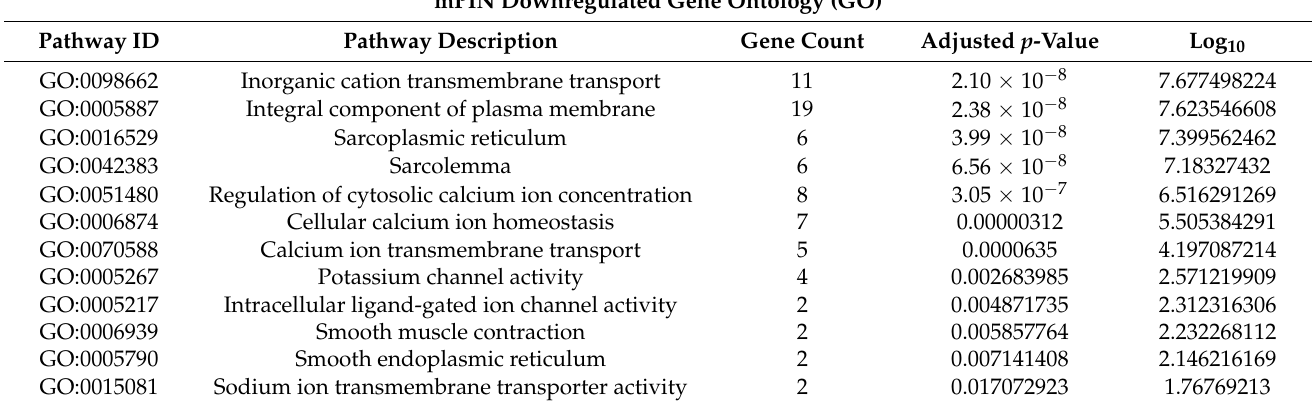
Table 3. A gene ontology (GO) enrichment analysis of membrane proteins downregulated in mPIN, MT, and AT of prostate